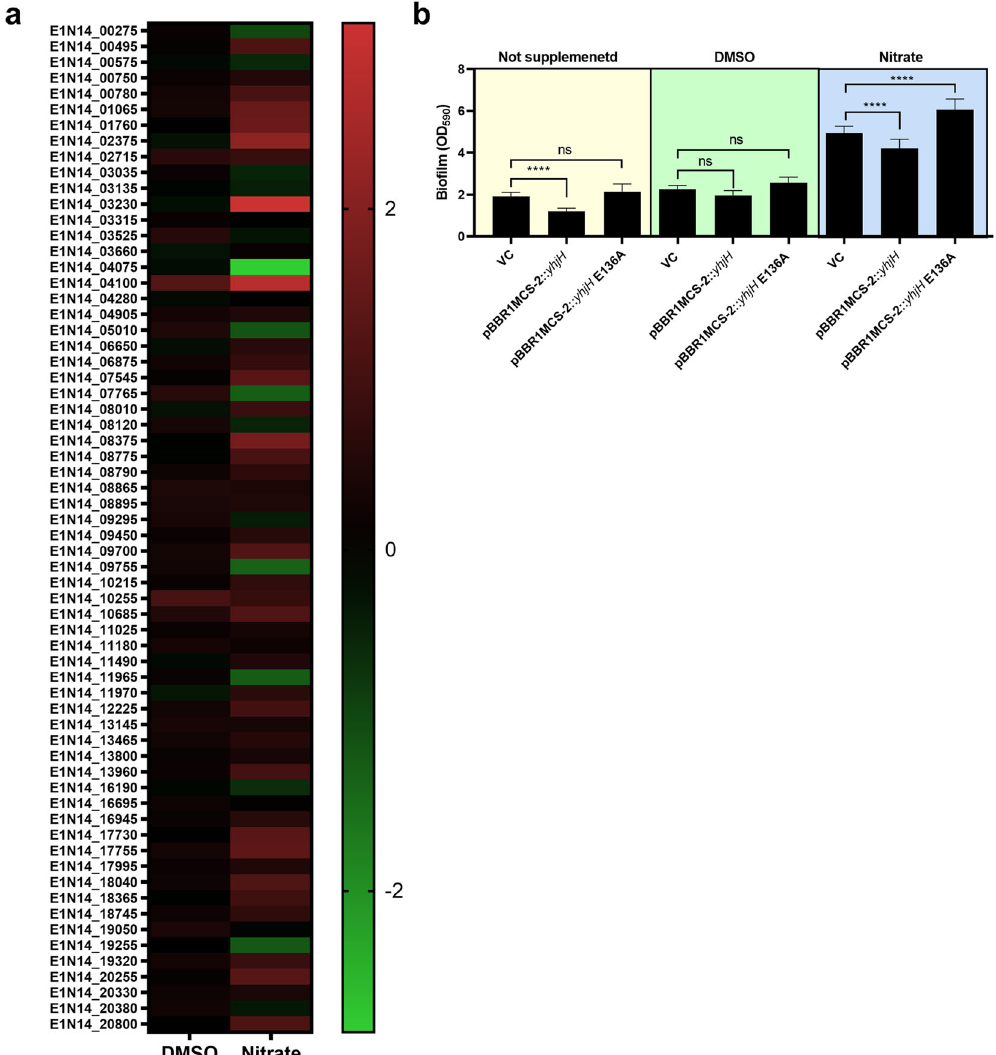
Fig. 7 Putative role of c-di-GMP signaling on AEA-induced bio fi lm formation. a Heatmap showing transcriptional changes (log 2 fold- change) of genes encoding putative c-di-GMP turnover proteins upon DMSO or nitrate supplementation. b Bio fi lm formation of S. algae CECT 5071 WT harboring the empty plasmid pBBR1MCS-2 (denoted as VC for “ vector control ” ) or expressing the PDE from S . Typhimurium YhjH or the catalytically inactive derivative YhjH E136A cloned in this plasmid in the absence or in the presence of 35 mM DMSO or nitrate. Data represent the average and SD of three biological replicates with seven technical replicates per sample. Statistical signi fi cance of the differences was determined by one-way ANOVA followed by Tukey ’ s post-hoc test (**** P < 0.0001, ns not signi fi